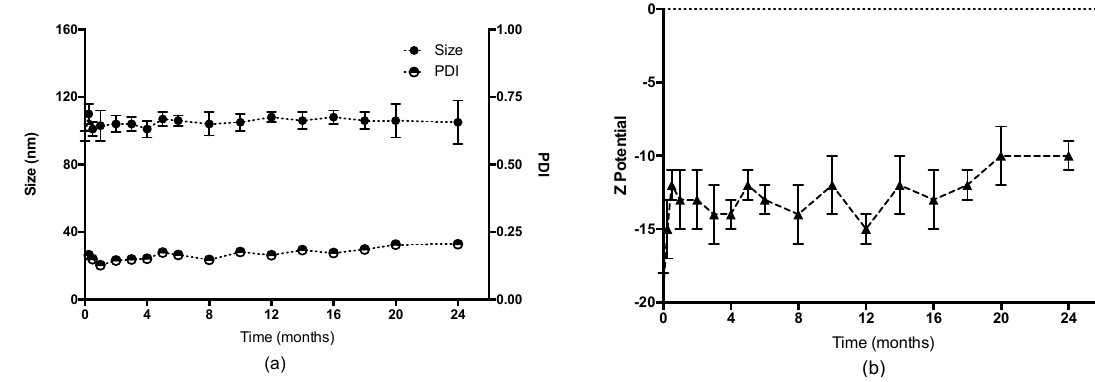
Figure 3. Stability of Hyaluronic acid nanocapsules at 4 ◦ C for 24 months. ( a ) Particle size and polydispersity index (PDI), ( b ) zeta potential.